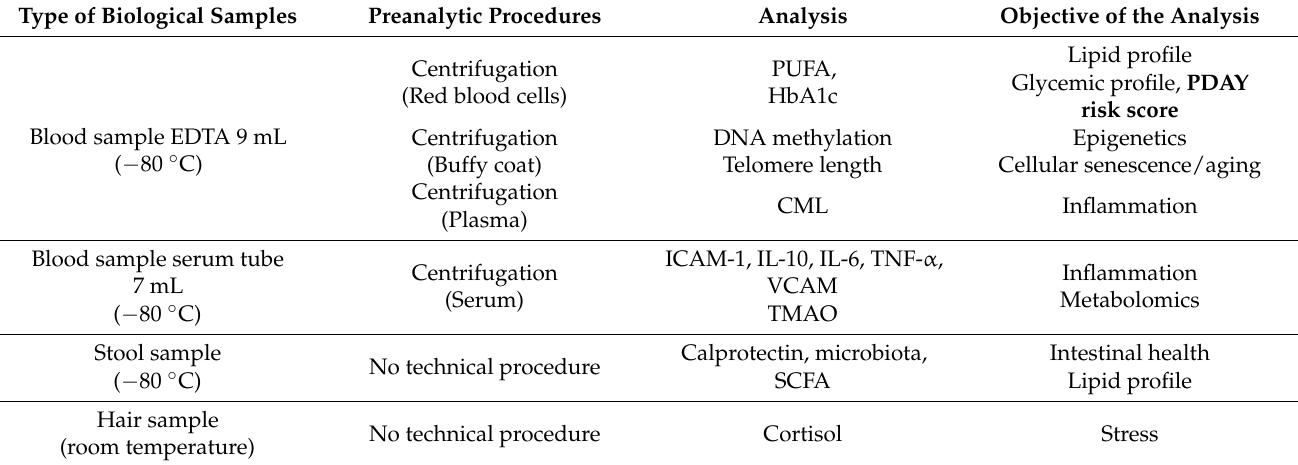
Table 3. Blood, stool, and hair samples, preanalytic procedure, and parameters for BELINDA